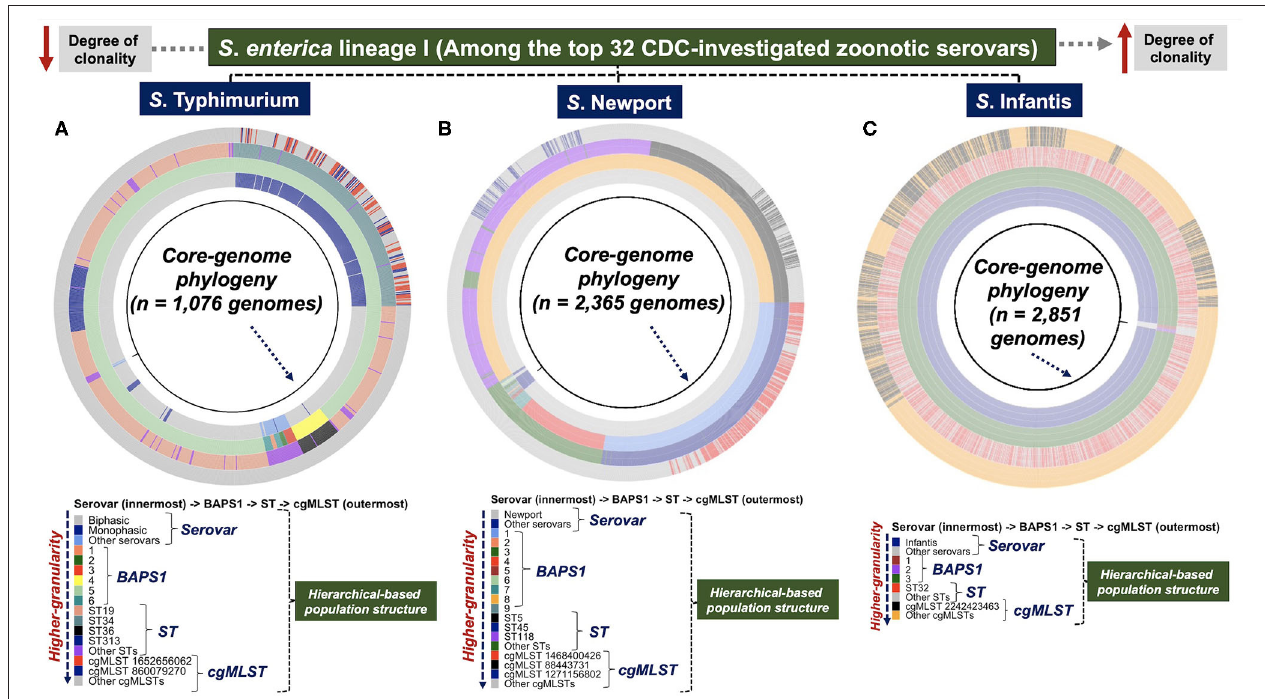
FIGURE 2 | Phylogeny-dependent hierarchical-based population structure analysis of three distinct serovars of S . enterica lineage I showed unique genomic diversity and topology. Three zoonotic serovars of S . enterica lineage I, with varying degree of clonality and population structure, were selected for a heuristic phylogeny-guided population-based genomics analysis, and included: (A) S . Typhimurium ( n = 1,076 genomes—group 1 of 20 data subsets) and (B) S . Newport ( n = 2,365 genomes) which are less clonal (i.e., higher degree of genotypic heterogeneity); and the highly clonal population of (C) S . Infantis ( n = 2,851 genomes). Of note, for S . Typhimurium (A) , subset/group 1 out of the 20 randomly generated subsets is shown in the Figure. These serovars belong to a list of the top 32 most investigated populations related to recent human outbreaks, as reported by the CDC. A core-genome phylogeny (black ring) was used as a genomic anchor to position each genome, and show their genetic relationships. Phenotypes and genotypes, comprising a hierarchical-based classification system were mapped onto the phylogenetic tree, including: serovars (1st colored ring) at the lowest level (can be generated phenotypically or predicted genotypically by SISTR), BAPS1 (2nd colored ring), ST (3rd colored ring), and cgMLST (4th colored ring) at the highest level of genotypic resolution. This hierarchical-system used a top-down approach that facilitates visualization of the familial genetic relationships across populations, as well as the degree of clonality based on the distribution of BAPS1, ST, and cgMLST genotypes. A more clonal population depicts lower BAPS1, ST, and cgMLST genetic diversity. As the classification systems moves outward across the tree from serovars to cgMLST, the degree of genotypic resolution increases. The initial NCBI-SRA downloaded genomic sequence sample size (i.e., accession list of SRA identifications selected for analysis) for each serovar was: S . Typhimurium ( n = 23,045—“Worldwide”), S . Newport ( n = 2,392—“USA only”), and S . Infantis ( n = 2,870—“USA only”). The S . Typhimurium dataset was randomly split into 20 subsets containing from 1,076 to 1,077 genomes each. While processing through ProkEvo, low quality assemblies are filtered out, thereby explaining the difference in counts for each serovar from downloaded to ultimately analyzed genomes used for ecological and epidemiological inferences. Of note, “Other serovars” represents serovars that were either not classified as any of the three ones used in this paper, or were misclassified by SISTR within ProkEvo. The groups called “Other STs” or “Other cgMLSTs” corresponded to minor variants present in each respective population. Core-genome phylogenies was visualized using